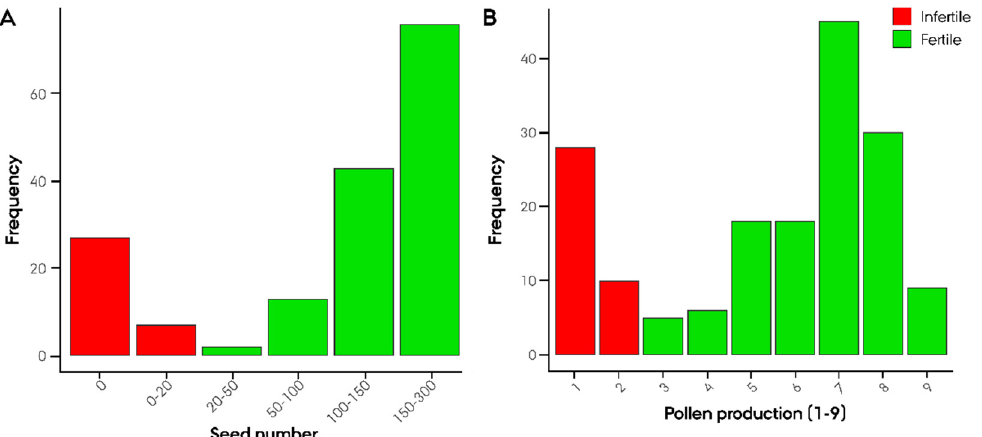
Figure 2. Phenotypic distribution of restoration of male-fertility-related traits. ( A ) Seed number and ( B ) pollen production in 181 F 2 plants derived from a ‘Gülzow’ type hybrid rye ( Secale cereale L.) cv. Stannos.